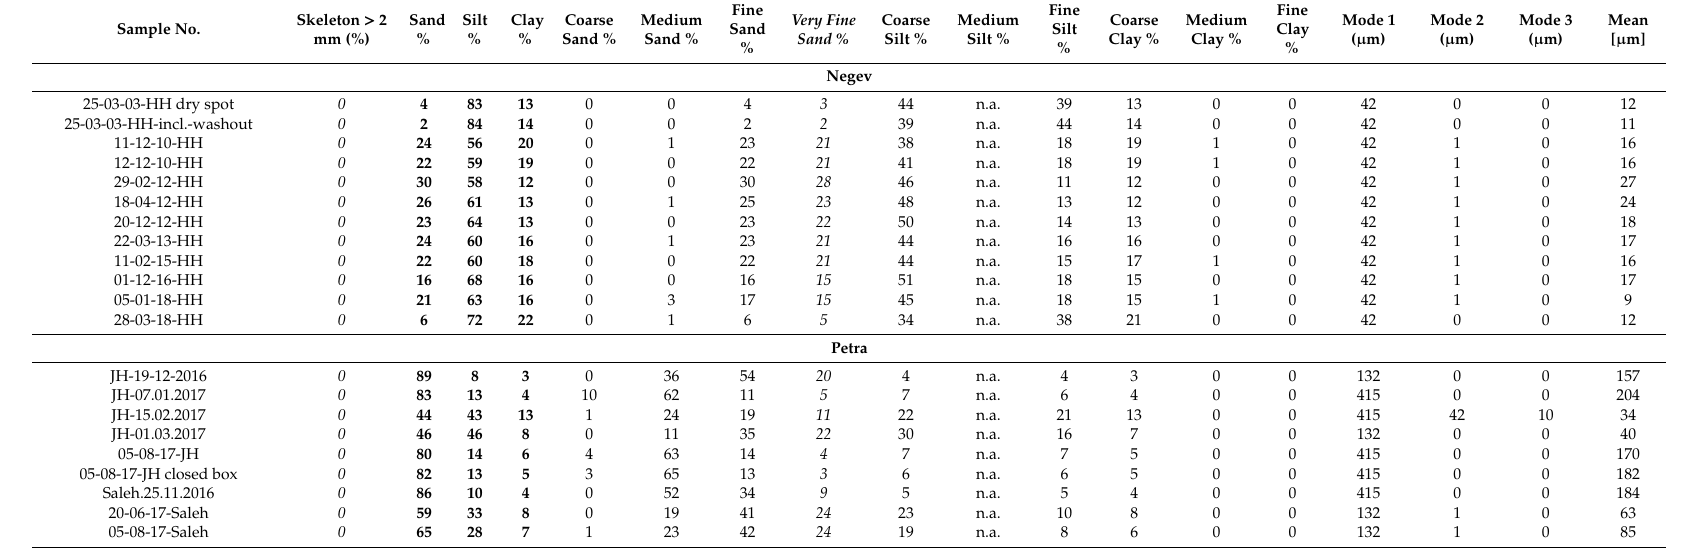
Table A4. Results of particle size analysis of the current dust samples from Petra region and the Negev by laser grain size analysis with assumed clay-silt border of 5 µ m in order to maximize comparability with Sedigraph results and respective statistical parameters. Note that the very fine sand (in italics) is part of the fine sand fraction. Skeleton is shown as well (in italics), and summarizing grain size units (in bold). The medium silt fraction is mathematically eliminated due to the adapted clay